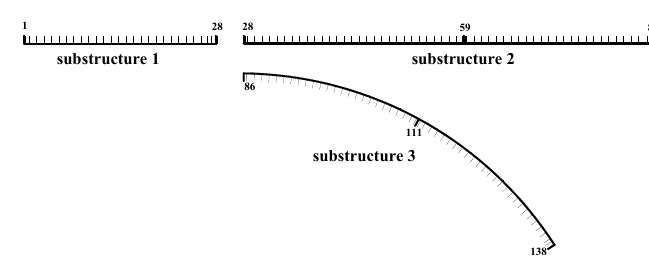
Figure 5. Substructure partition of the typical irregularly-shaped bridge model.